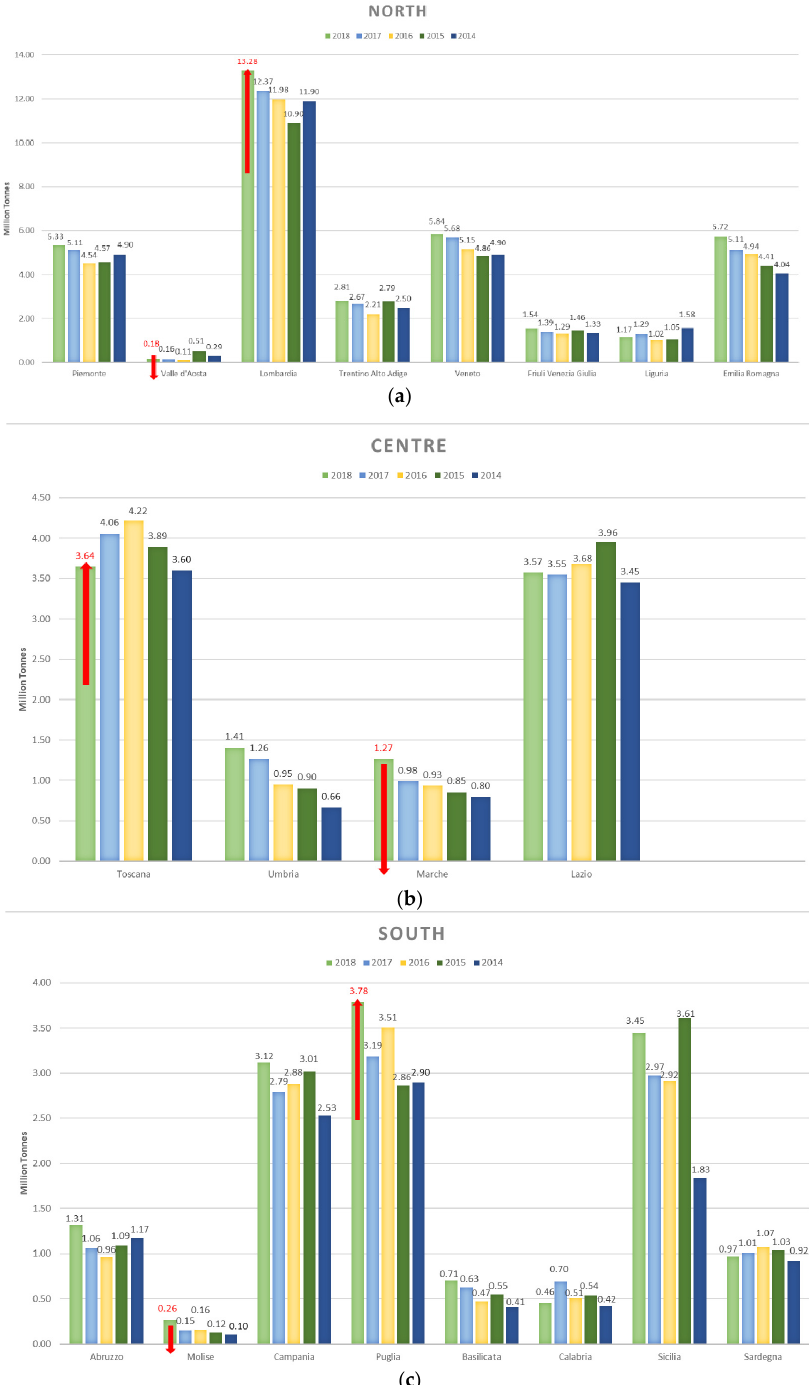
Figure 5. ( a ) C&D waste production in the northern regions of the country. Source: Own elaboration from ISPRA data. ( b ) C&D waste production in the northern regions of the country. Source: Own elaboration from ISPRA data. ( c ) C&D waste production in the northern regions of the country. Source: Own elaboration from ISPRA data. The one with the highest rate of production is Lombardia with more than 13 million tonnes of waste in 2018. This region is the biggest one in the country, with a fervent in- dustrial activity, and this data is a clear reflection of its status. Even in 2014 the produc- tion of waste of this area of Italy presented a level of material production up to 11 mil- lion tonnes, the highest rate among all the regions that are part of the north area. Small regions such as Valle D’Aosta, with a difficult environmental landscape, where its strong points are not in its industrial production but in its nature and territory, are the ones with low waste production, reaching less than 0.18 million tonnes per year [4]. The situation in the centre is similar, with the bigger quantity of waste grouped in the larger regions such as Toscana with a value up to 3.6 million tonnes of waste in 2018, followed by Lazio with 3.5 million in 2018. In the centre, because the number of regions that comprise it is reduced, the results are more homogeneous with two regions with